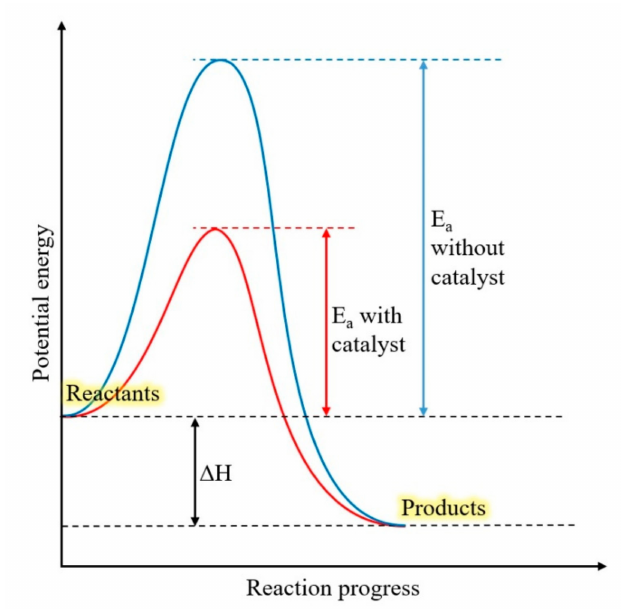
Figure 1. E ff ect of catalyst on energy diagram profile.